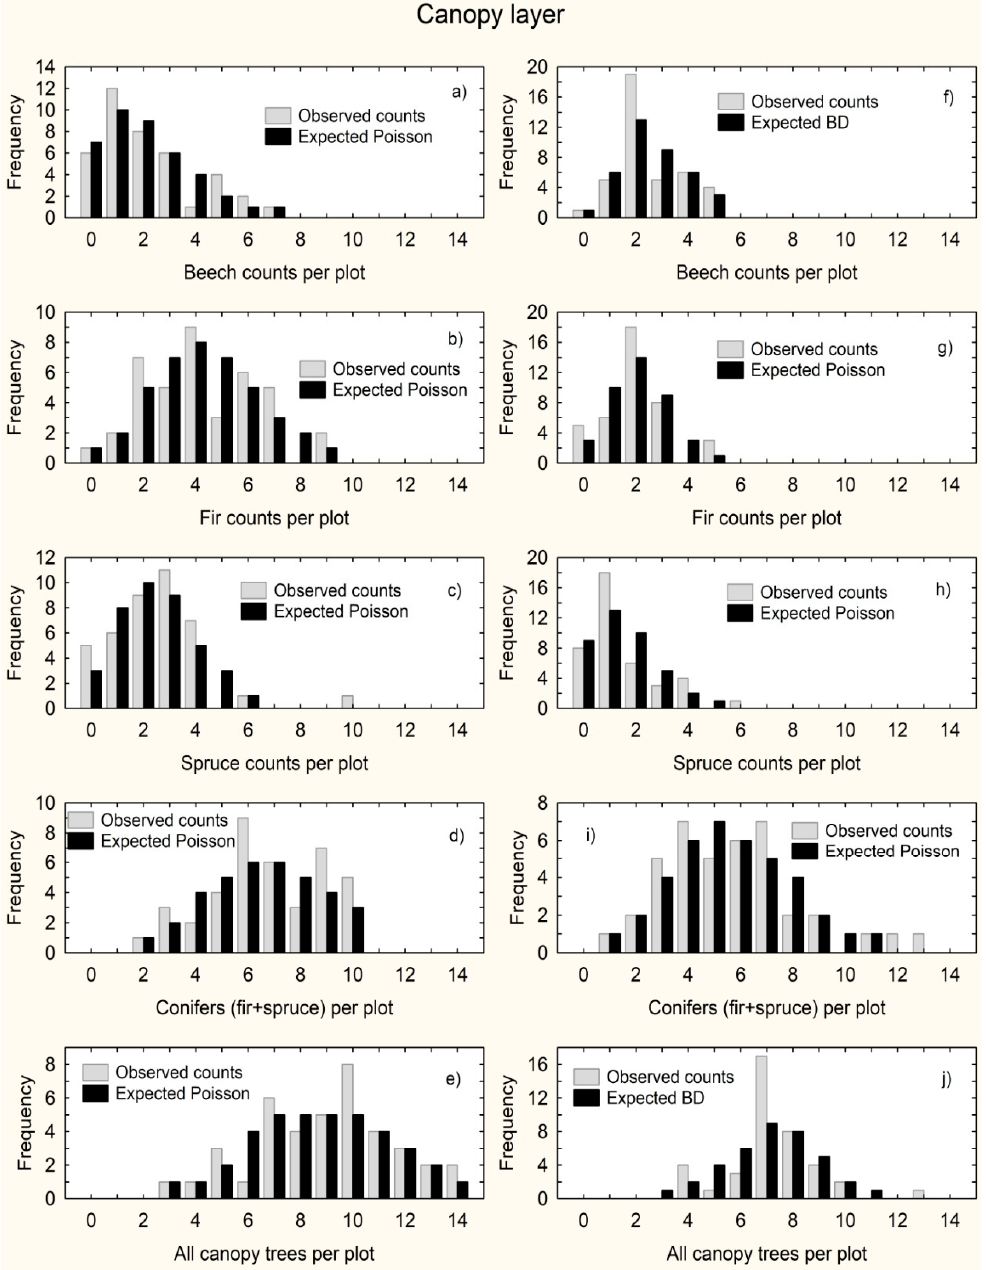
Figure 2. The observed and expected tree counts for individual tree species, for conifers combined, and for all species combined in the canopy layer (trees with DBH > 27.5 cm) in the Janj (left: a , b , c , d , e ) and Lom (right: f , g , h , i , j ) old-growth forests. The expected counts were based on the models that best fitted the observed counts of canopy trees: Poisson distribution and binomial distribution (BD).